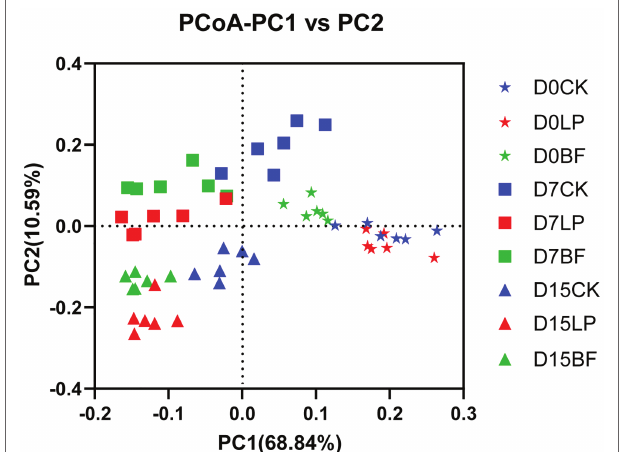
FIGURE 2 | Principal coordinates analysis (PCoA) analysis of bacterial community structure of corn stalk silages treated without (CK) or with L. plantarum and BF. D0, D7, and D15 indicated stay-green corn stalks after 0, 7, and 15 days of ear harvest.